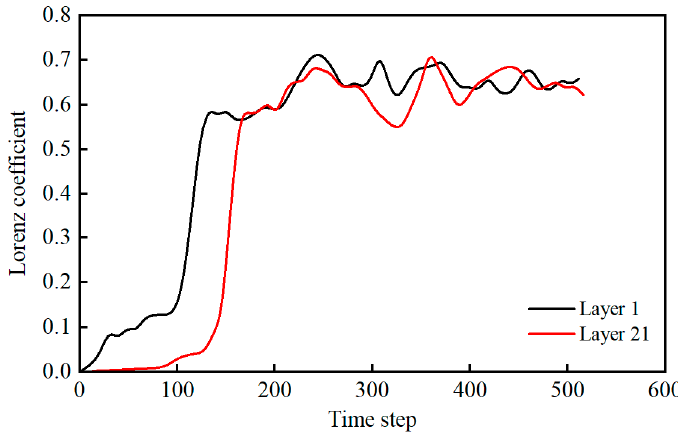
Figure 23. Variation of flow heterogeneity curves during waterflooding.